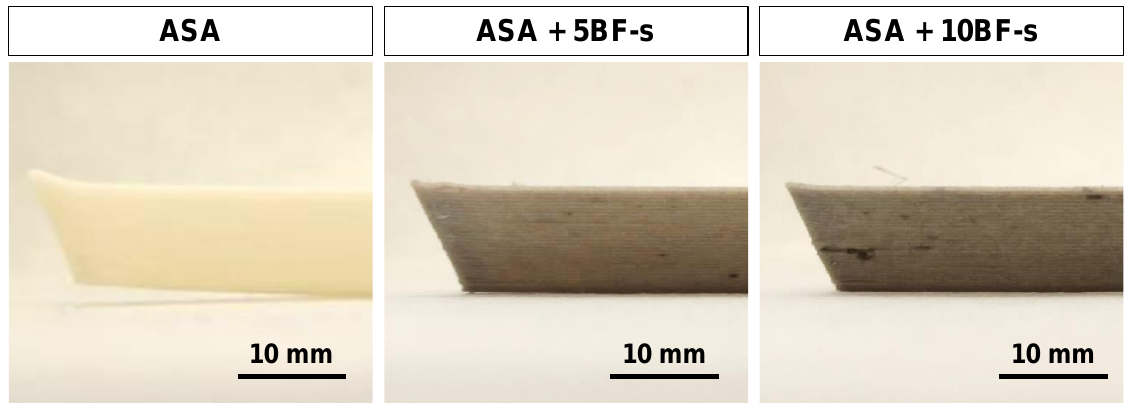
Figure 9. Side view of warping parts printed in ASA, ASA + 5BF-s and ASA + 10BF-s.